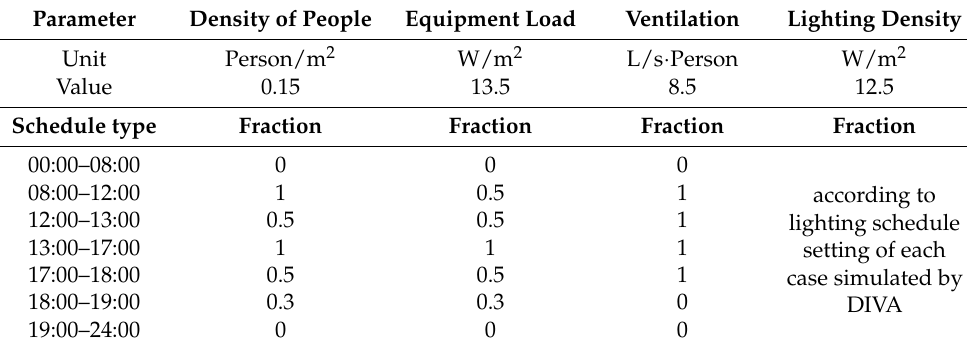
Table 8. Indoor conditions and hourly load change rate setting of the office